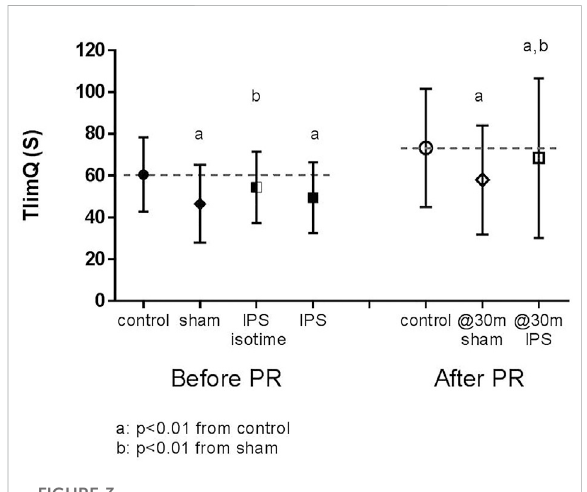
FIGURE 3 Effect of IPS and exercise training on quadriceps endurance (TlimQ). Dotted line corresponded to mean control value.